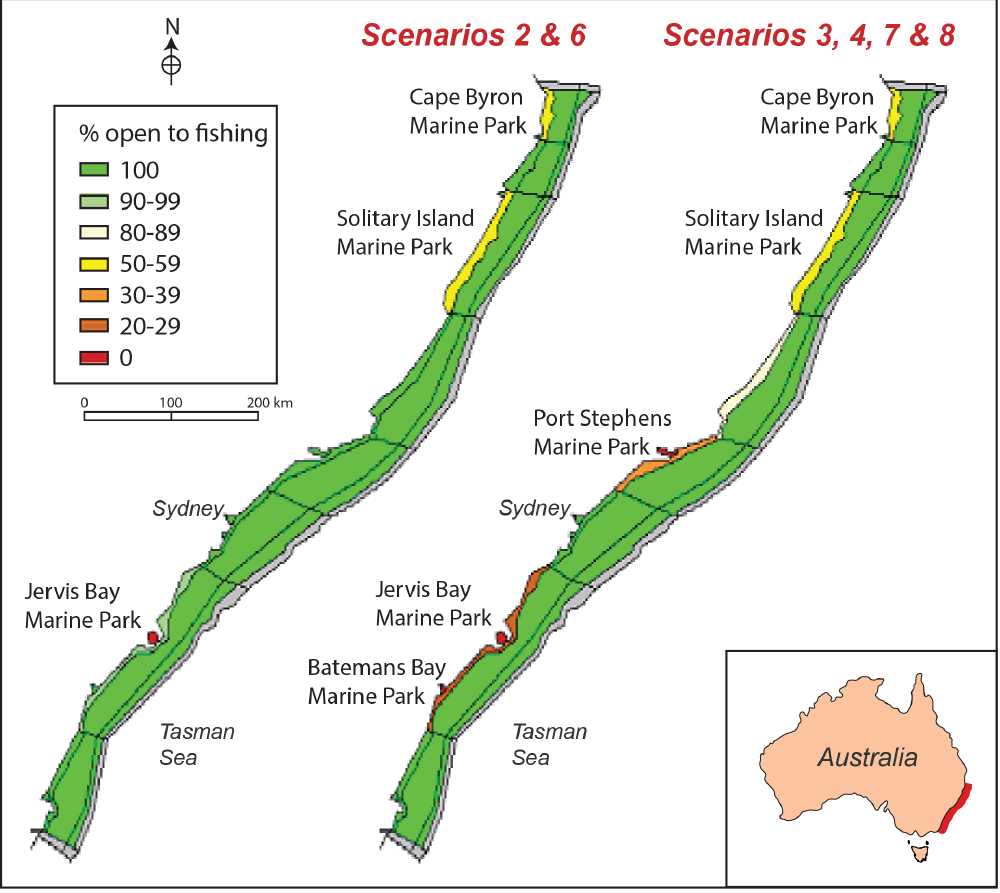
Figure 1. Polygonal cell structure of the model and percentage of model cells open to fishing as a consequence of three marine reserves (left, scenarios 2 and 5) or five marine reserves (right, scenarios 3, and 6). More details in the text.